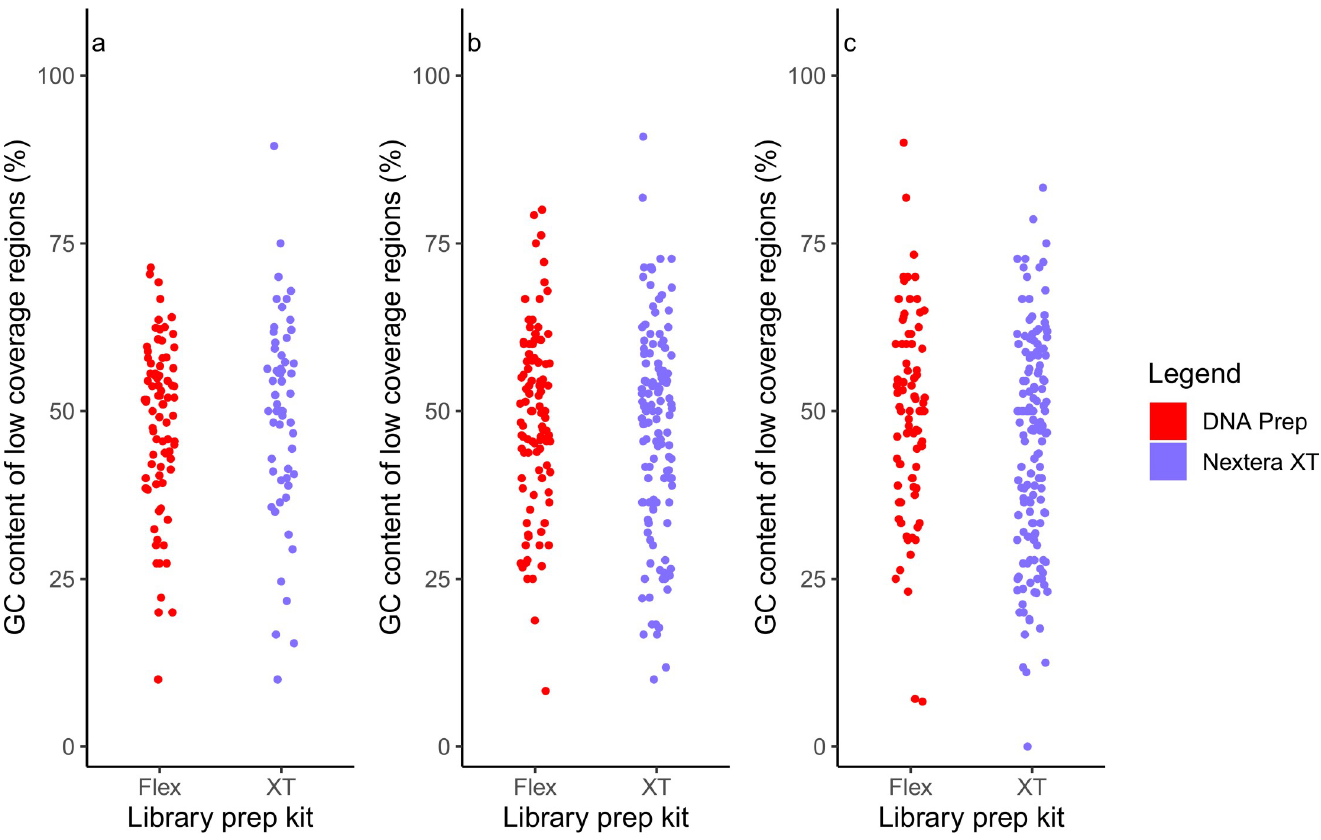
Fig 2. The relationship between GC-content and low coverage regions of the E . coli chromosome. (A-C) Graph displays the GC-content percentage of low coverage regions (coverage less than 5, each region of length greater than 10 bp) of each representative E . coli